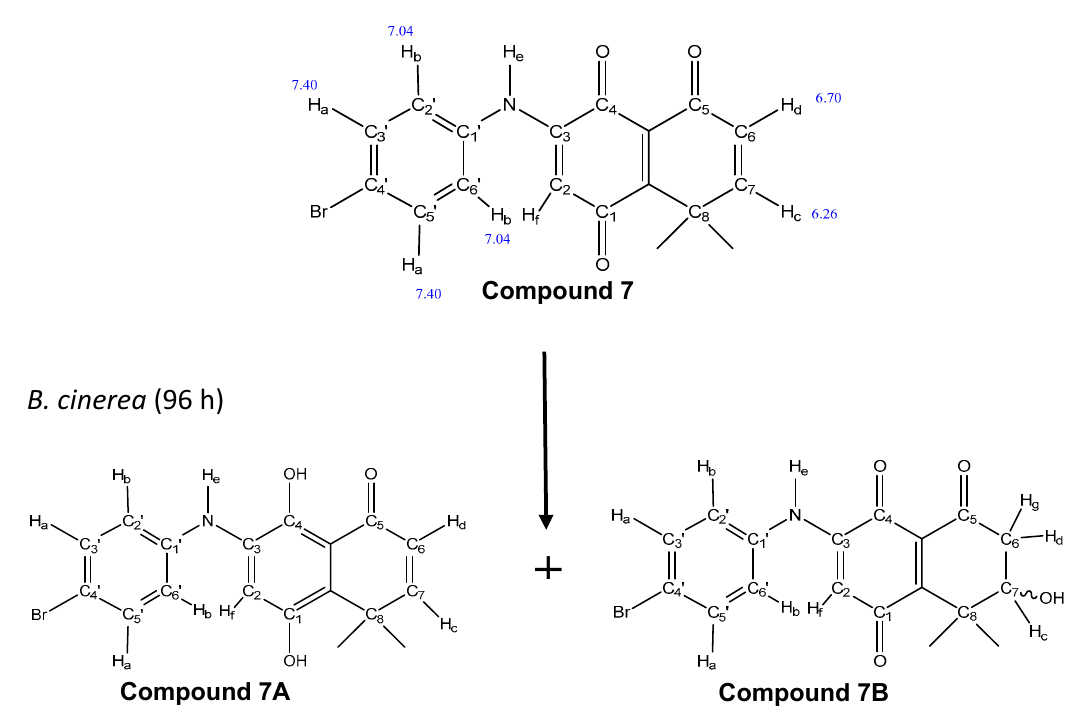
Figure 4. Proposed structures ( 7A and 7B ) of the biotransformed compounds by the fungus B.cinerea